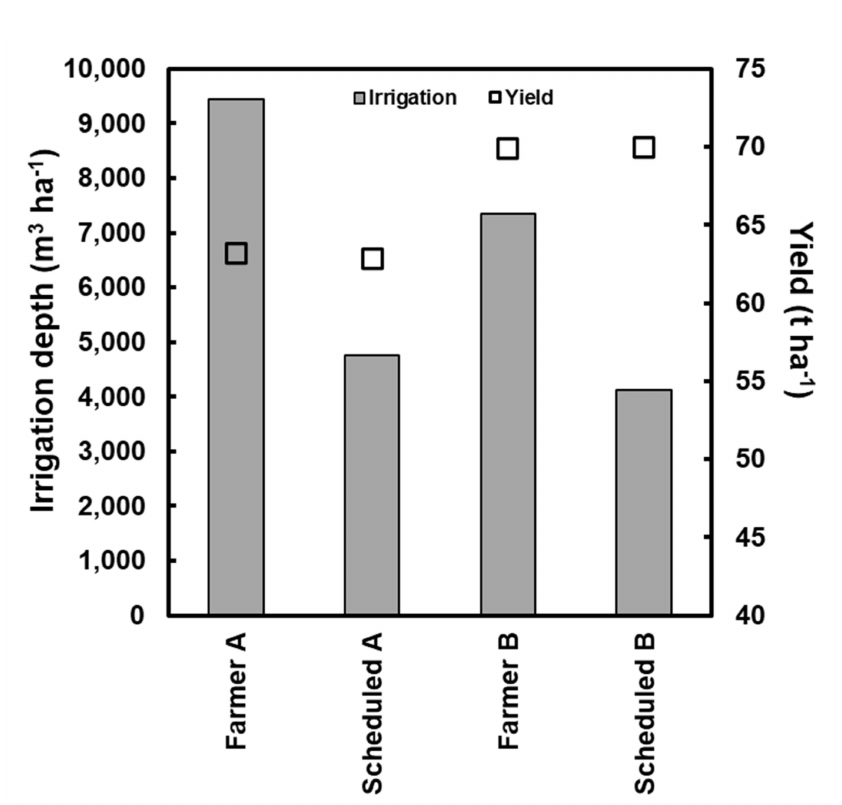
Figure 4. Irrigation depth and yield in two strawberry trials during the 2013/14